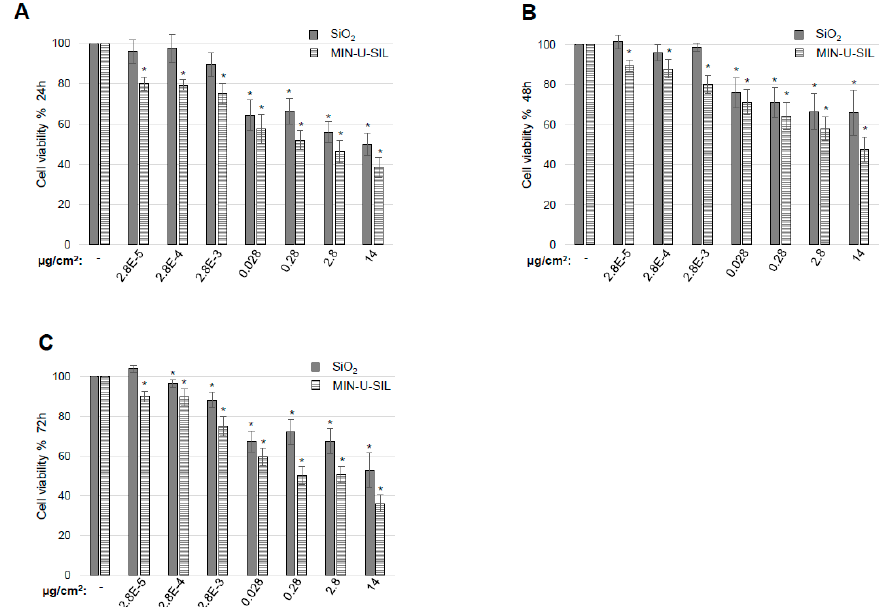
Figure 3. Dust-induced cytotoxicity and gap junctional intercellular communication is dose- and time-dependent. Astrocytoma cells were grown and exposed to control media or to the dust at the indicated concentrations for ( A ) 24, ( B ) 48 and ( C ) 72 h before measurement of cellular cytotoxicity. Cell viability of control-treated cells was set to 100%. An average of three independent experiments in triplicate is shown.